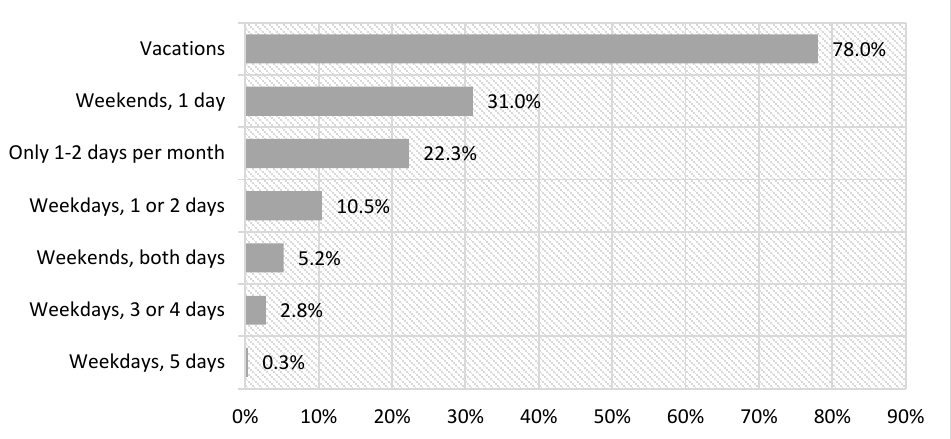
Figure 4. Frequency of shared practice of festive leisure.